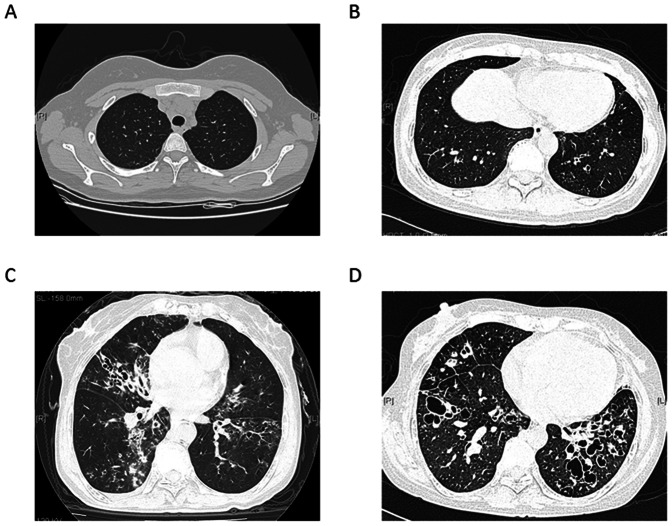
HRCT grading system for patients with bronchiectasis.Each lobe of both lungs is graded for bronchiectatic changes on a scale of 0 to 3 (lingula was scored as a separate lobe), giving a maximum of 18 points. (A) Represents score 0: no bronchiectasis. (B) Represents score 1 in one lobe: one bronchopulmonary segment involved (C) Represents score 2 in one lobe: more than one bronchopulmonary segment involved. Total Score was 8 in this figure due to four lobes involved. (D) Represents score 3 in one lobe: grossly cystic bronchiectasis. Total Score was 12 in this figure due to three lobes involved.